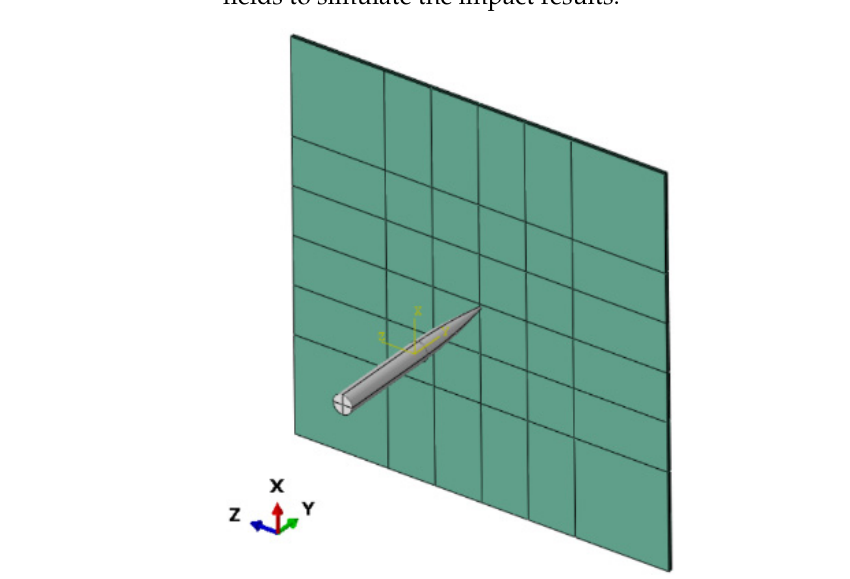
Figure 7. Finite element model.